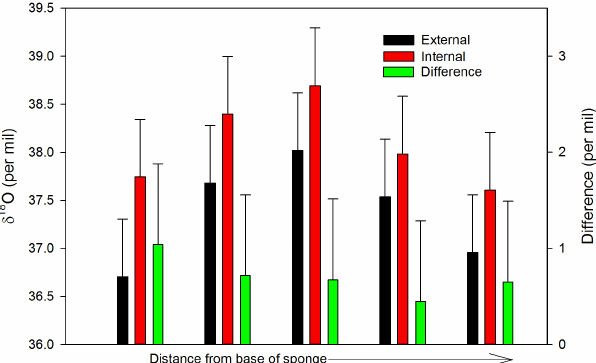
Figure 4. δ 18 O values for subsamples of DH19-2. Red bars show the internal interlocking framework, black bars show the external loose spicules, and green bars show the difference between the in- ternal and external spicules. Error bars show external reproducibil- ity from replicate standard measurements